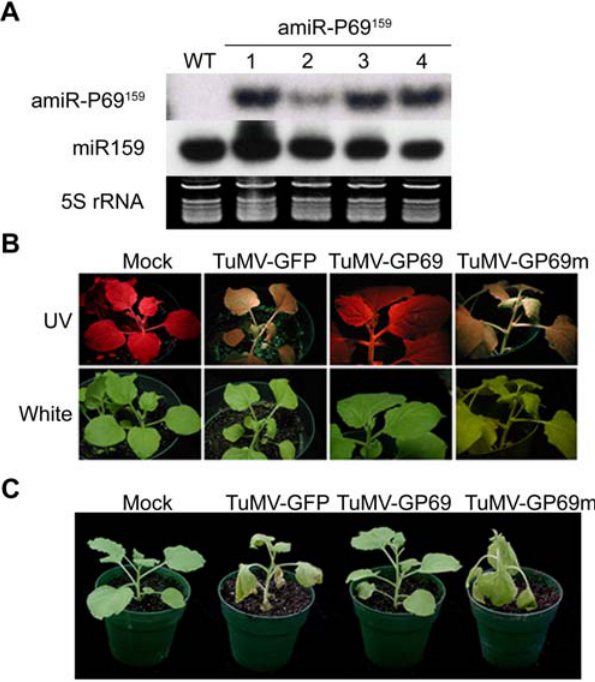
Figure 3. Transgenic N.benthamiana plants expressing amiR 159 - P69 are resistant to infection by chimeric TuMV virus. (A) amiR 159 - P69 expression levels of transgenic N. benthamiana plants carrying 35S-pre-amiR 159 -P69. Four independent lines ( # 1, 2, 3, and 4) were analyzed. 5S rRNAs were used as a loading control. (B) Early infection of chimeric TuMV viruses monitored by UV excitation. (C) amiR 159 -P69 N. benthamiana plants were resistant to TuMV-GP69 but susceptible to TuMV-GP69m or